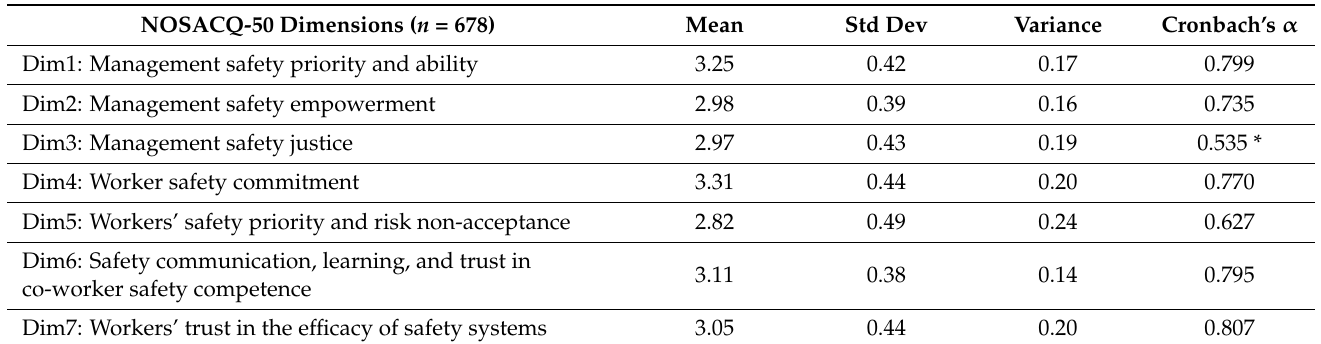
Table 4. Overall result of safety climate assessment for each dimension. Safety climate score means in a scale of 1–4.